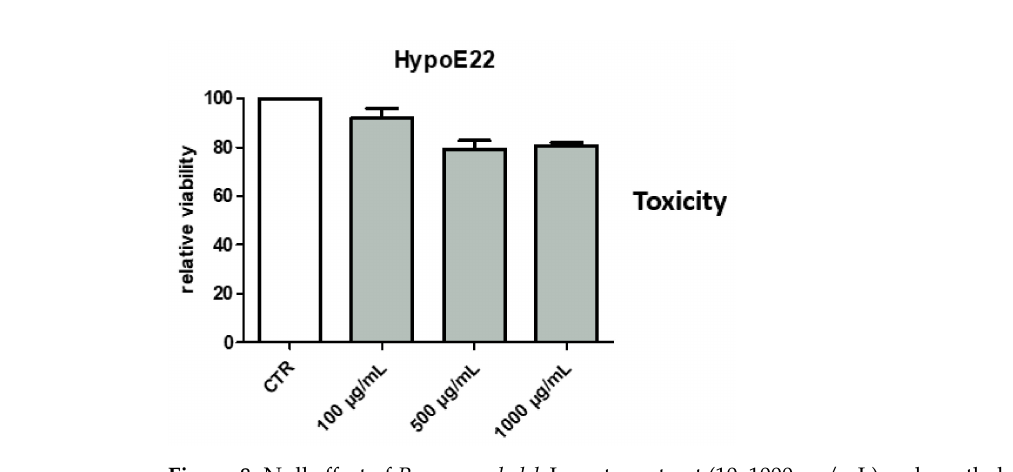
Figure 8. Null effect of Prunus mahaleb L. water extract (10–1000 µ g/mL) on hypothalamic HypoE22 cell viability.